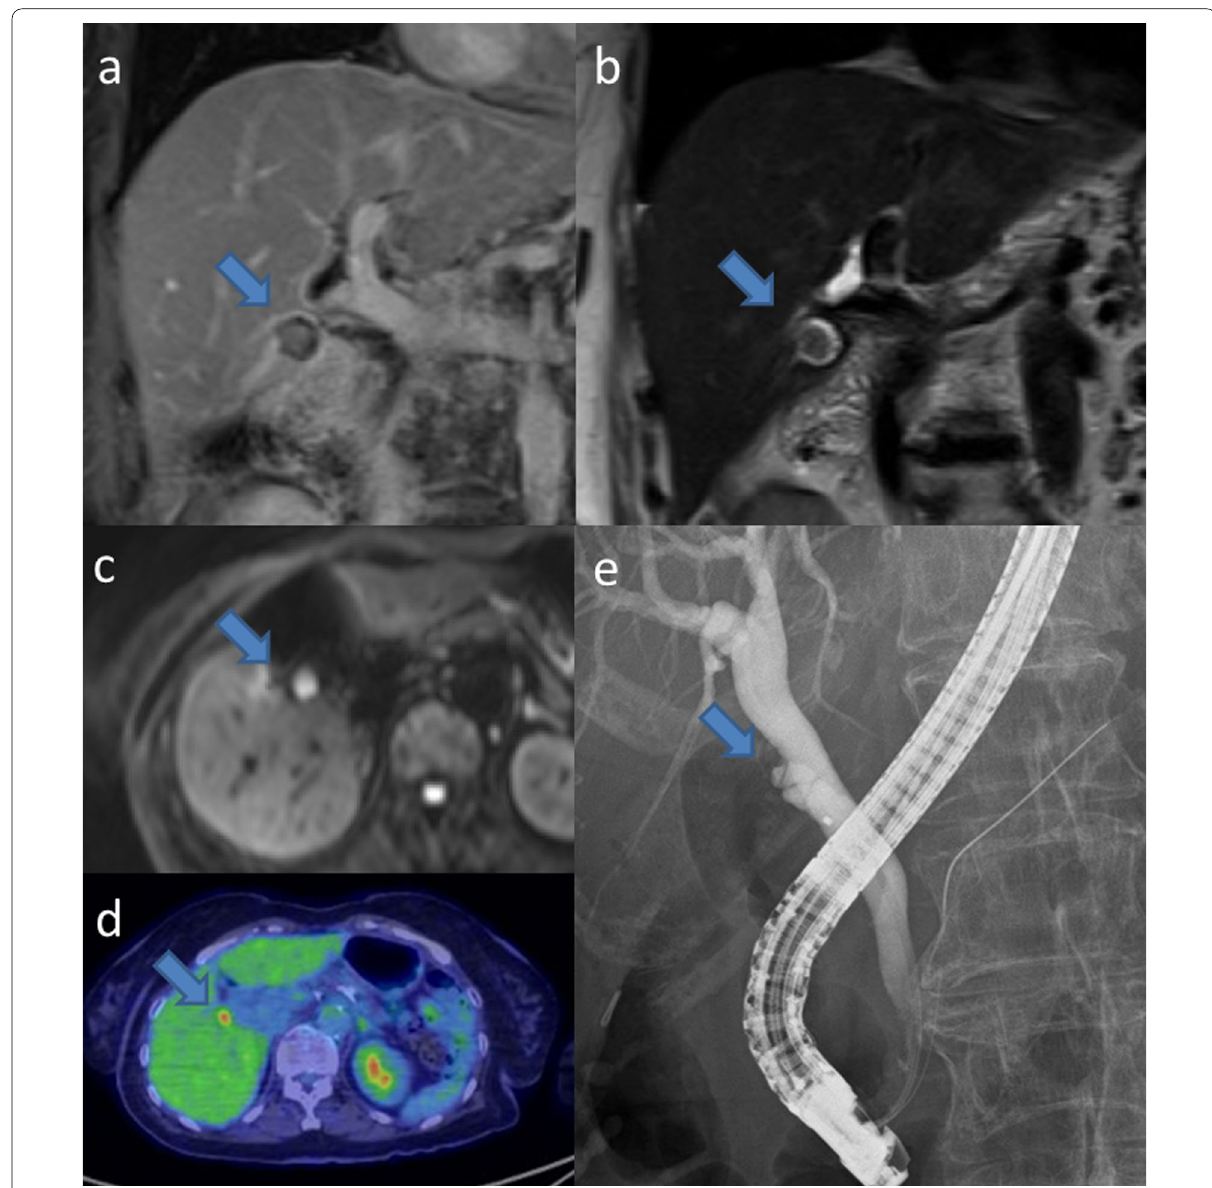
Fig. 3 Findings of additional imaging studies. a T1-weighted magnetic resonance imaging (MRI). A 10-mm enhanced nodule is visible (arrow) without evidence of extramural invasion. b T2-weighted MRI. The lesion is detected as a filling defect (arrow). c Diffusion-weighted MRI. Restricted diffusion of the lesion is observed (arrow). d 18-fluoro-2-deoxy-glucose positron emission tomography/computed tomography (FDG-PET/CT). FDG accumulation (maximum standardized uptake value: 6.90) in the remnant gallbladder lesion is observed (arrow). e Endoscopic retrograde cholangiopancreatography. The cystic duct, which diverged from the left side of the middle bile duct, was confirmed. Findings suspicious for invasion to the bile duct and pancreatobiliary maljunction are not observed. Contrast medium did not flow into the remnant gallbladder via the cystic duct (arrow). The length of the intact cystic duct was approximately 15 mm. According to the cholangiography findings, extrahepatic bile duct resection was planned to be